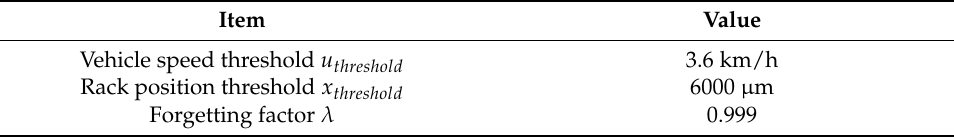
Table 2. Parameter settings of the fusion-based MCPE. Item